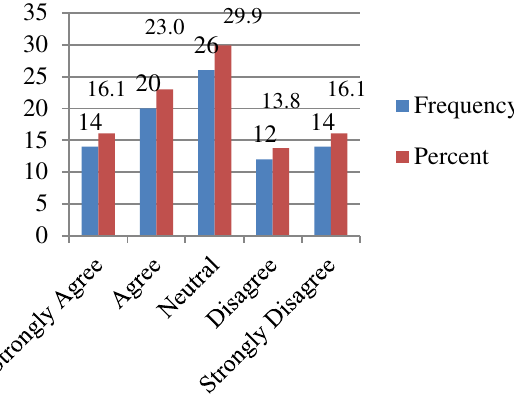
Fig. 6. Respondent’s perception on competition can put Fig. 8. Respondent’s pe rception of influence religions more pressure Figure 8 indicates that the majority of respondents Figure 6 indicates that the majority of respondents 26 (29.9 percent) were neutral regarding the 34 (39.1 percent) agreed that the customer’s statement that the customer’s perception can perception puts more pressure on the competition. promote certain religions to benefit in a business.